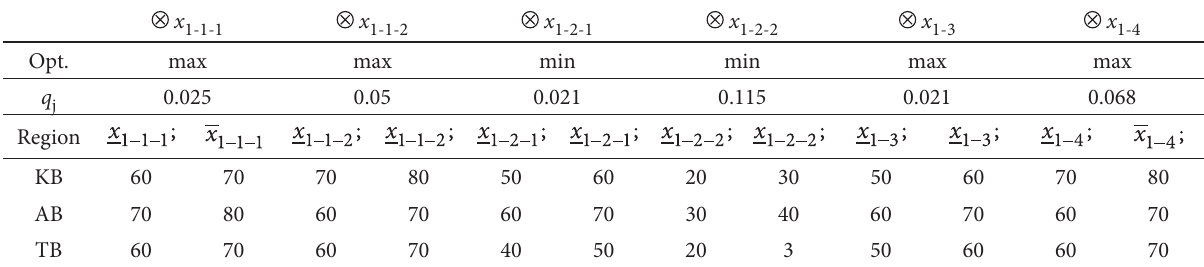
Table 9. Initial decision making matrix with the criteria values described in intervals